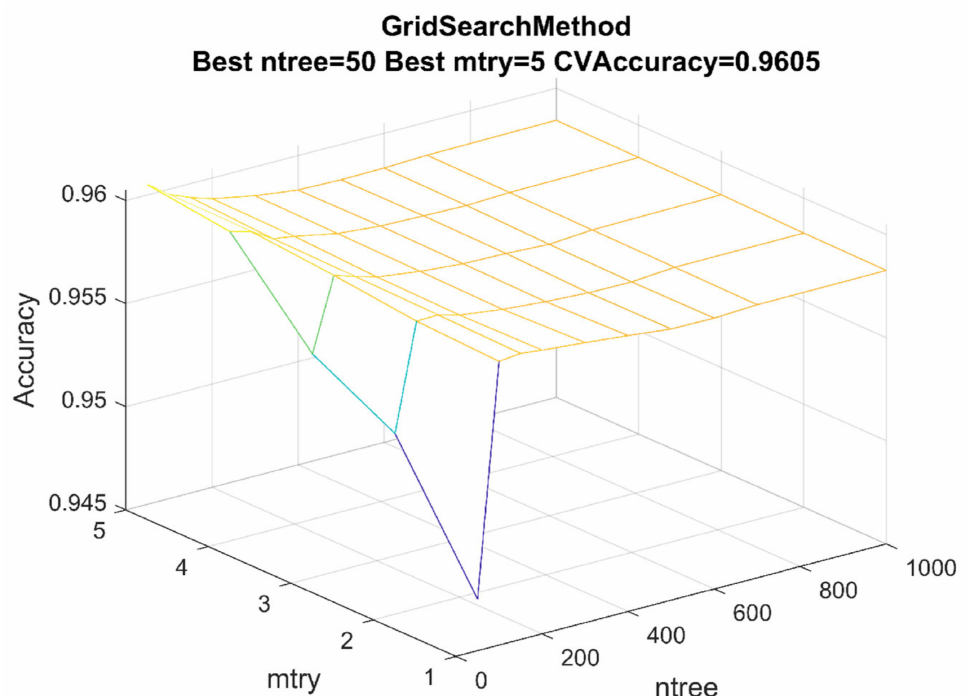
Figure 17. The results of the random forest grid search